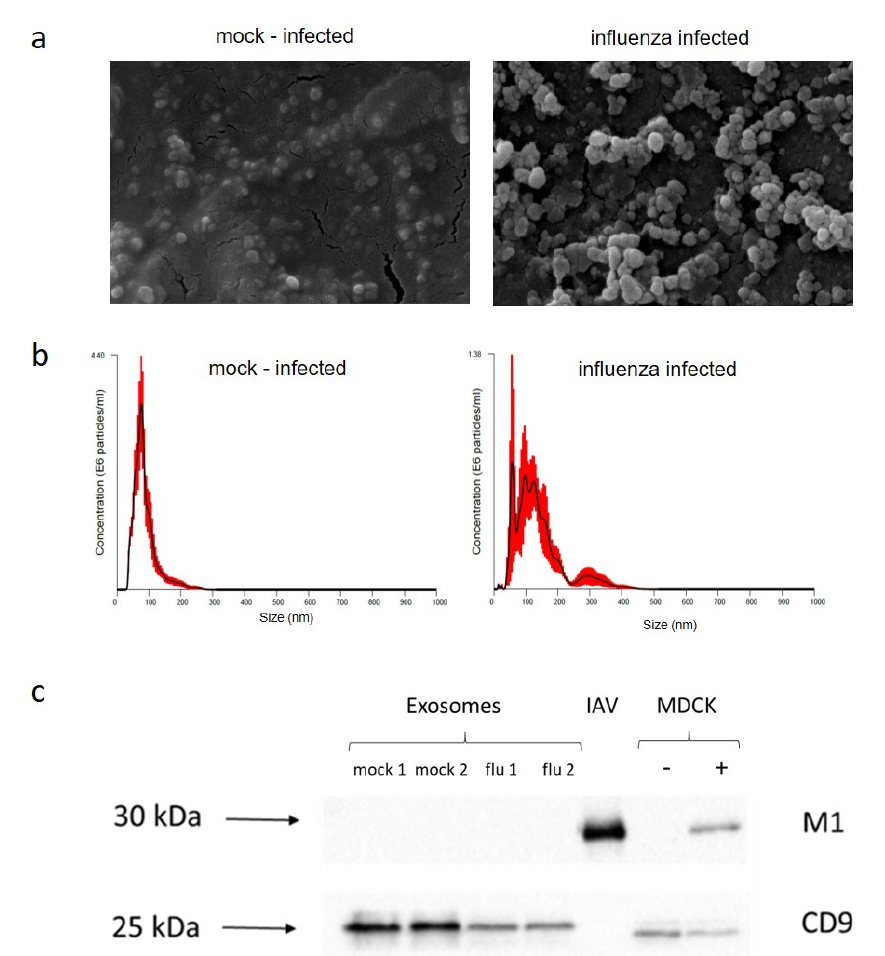
Figure 2. Identification and characterization of exosomes. ( a ) Scanning microscope photograph of purified exosomes. ( b ) Nanoparticle tracking analysis size distribution of exosomes isolated from mock-infected and influenza A virus (IAV)–infected MDCK cells. Red error bars indicate +/ − 1 standard error of the mean. ( c ) Immunoblotting of exosomal marker (CD9) and IAV matrix protein (M1). Exosomes secreted by mock–infected (mock 1, 2) and IAV infected (flu 1, 2) cells; IAV–influenza virions; MDCK–mock–infected ( − ) and IAV infected cells (+). Table 1. Numbers of reads mapped to Canis lupus familiaris (CanFam3.1, GCA_000002285.2)